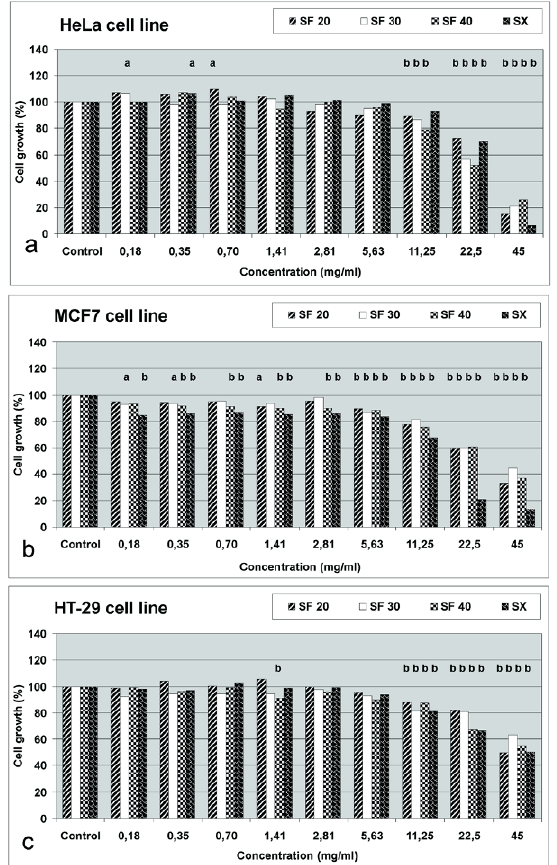
Figure 2. Cell growth activity of SF20, SF30, SF40 and SX paprika oleoresins in A) HeLa, B) MCF7 and C) HT-29 cell lines. (One way analysis of variance, compared to the control; a: p<0.05, b: p<0.01). Results are expressed as mean ± SD of two experiments, each performed in quadruplicate ( n =